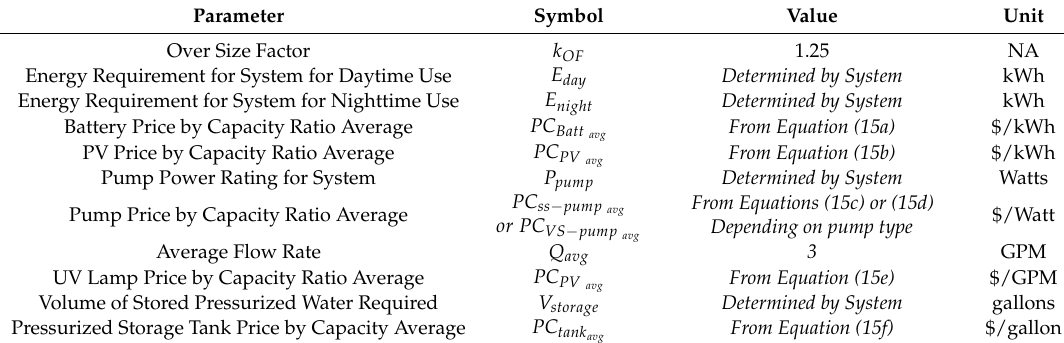
Table 11. Parameters for Equation (16) specifying parameter, symbol used, value and units used.